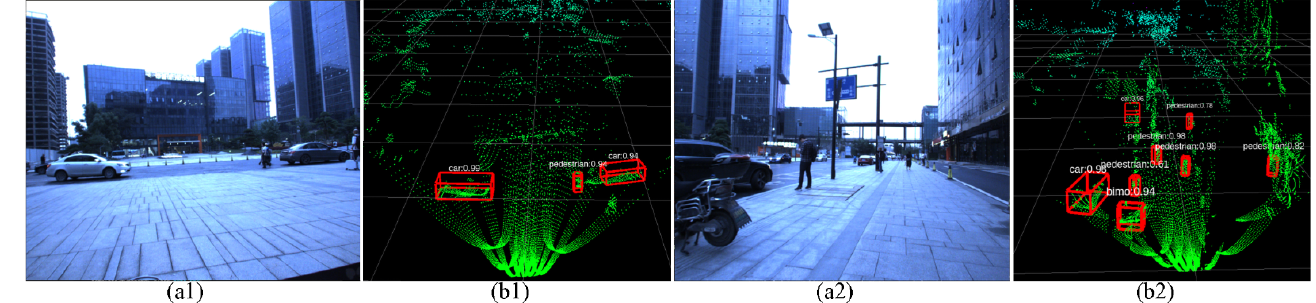
Figure 6. The object detection based on the point cloud: ( a1 , a2 ) the color images with zero-degree polarization; ( b1 , b2 ) the point cloud and the object detection and recognition results. The detection and recognition results are labelled using the red 3D bounding box. The class name and the confidence are put on the upper left corner of the bounding box.